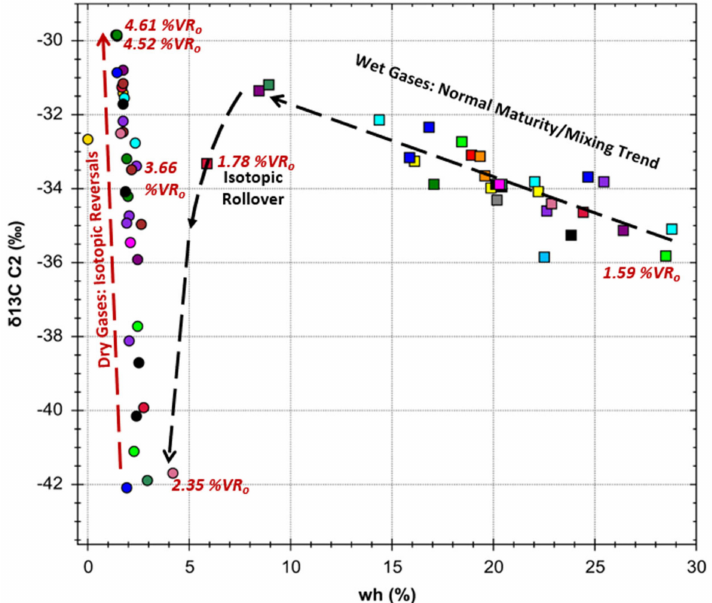
Figure 9. Plot of percent gas wetness (wh) against ethane δ 13 C for Marcellus Formation produced natural gases. VR o values noted next to selected data points were measured by Dr. Wayne Knowles, Stratum Reservoir. Dashed arrows show increasing maturity trends. Most wet gases follow a normal maturity trend with decreasing wetness accompanied by increasing δ 13 C 2 . Isotopic rollover [41,42] occurs at a wetness of about 5.9% where decreasing wetness is accompanied by 13 C depletion. Isotopic reversals [37,38,42,43] begin at a wetness of 4% where the dry gases exhibit decreasing wetness accompanied by rapidly increasing δ 13 C 2